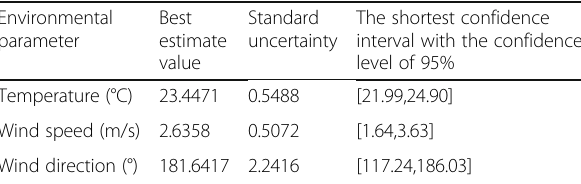
Table 5 MCM to analyze the output of environmental parameter uncertainty Environmental parameter